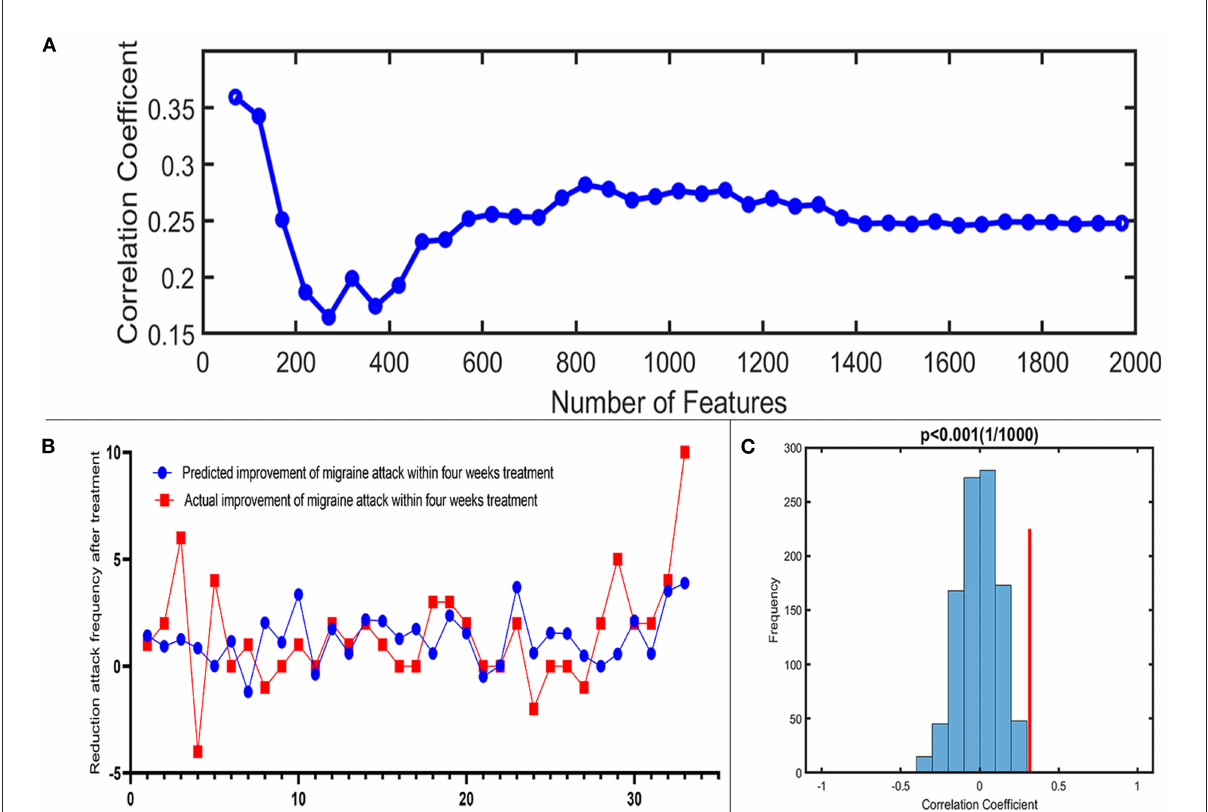
FIGURE4 Prediction performance of the proposed approach. (A) Line chart reflecting actual label and predictive label; when including 70 predictive features, the highest correlation coefficient is 0.36. (B) Correlation coefficient between the actual label and predictive label with the increased number of features in the reduction of migraine attack frequency. (C) The result of the permutation test with the highest correlation coefficient ( p < 0.001).